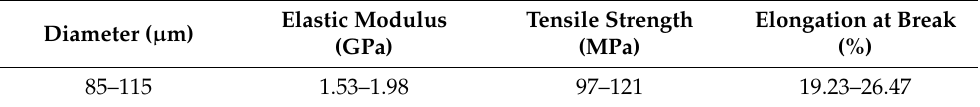
Table 2. The performance of the CHF used in the test.